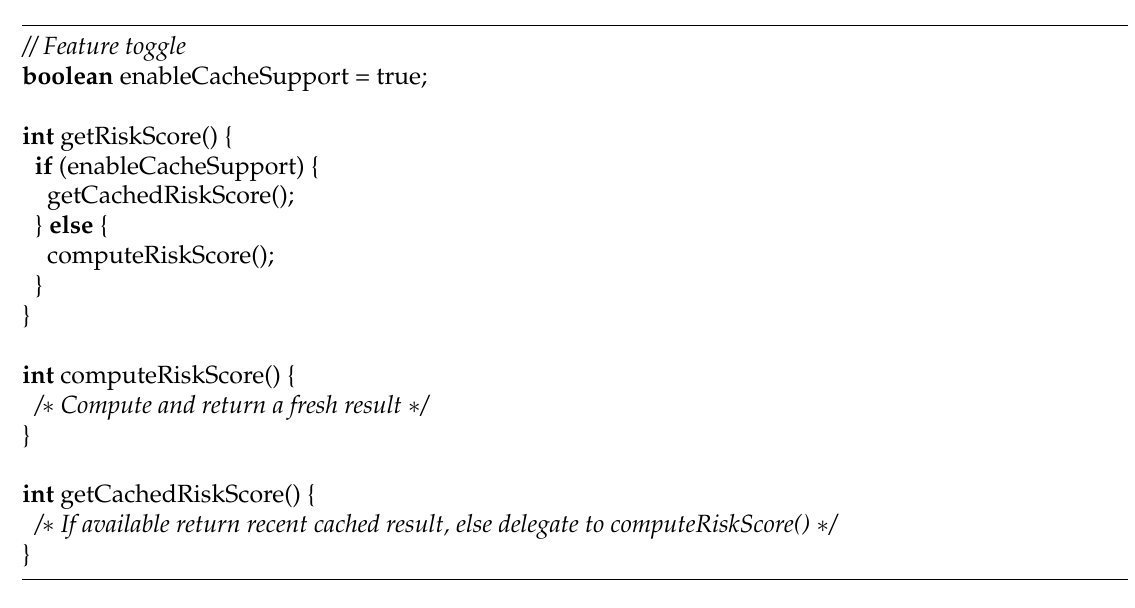
Figure 2. Feature toggles for returning cached results of a data-intensive process to improve performance.